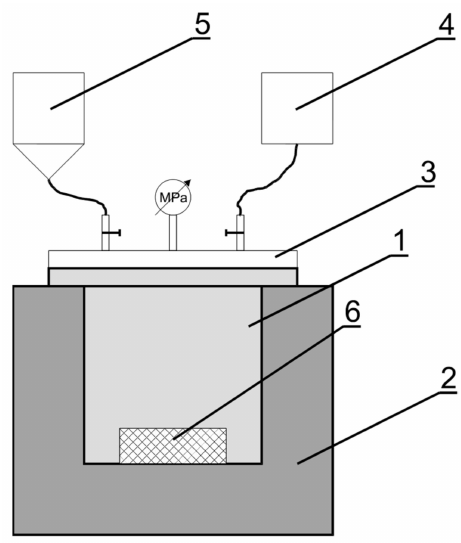
Figure 2. Scheme of the stand for vacuum impregnation process implementation: 1—vacuum chamber, 2—water bath, 3—cover, 4—vacuum pump, 5—reservoir for liquid, 6—reservoir for raw